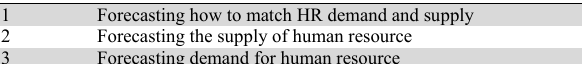
Ranking of job design sub-criteria